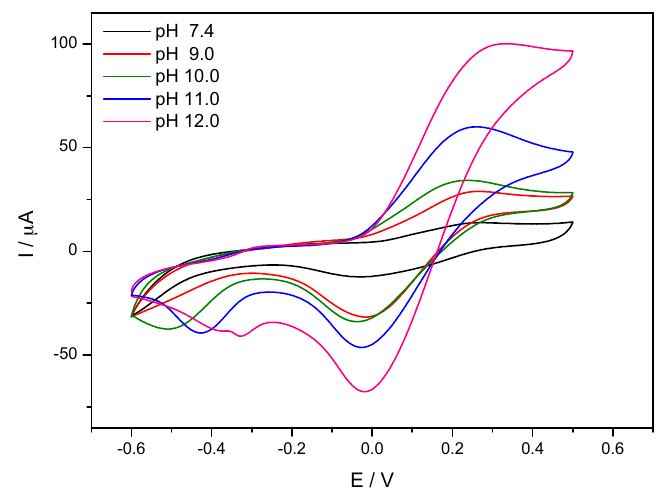
Figure 6. The influence of electrolyte solution pH on CVs of poly(2,6-DHN)/SPCE. PBS pH: 7.4, 9.0, 9.4, 10.0, 11.0, 12.0. Potential range: − 0.5 V to +0.5 V; scan rate: 100 mv · s − 1 ; sensor modified by electropolymerization of 2,6-DHN with the scan rate of 20 mV · s − 1 .